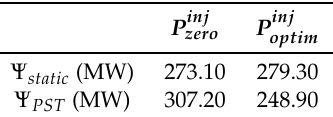
Table 7. Value at risk of 5% for the flows comparison between the full and reduced model, without an explicit PST